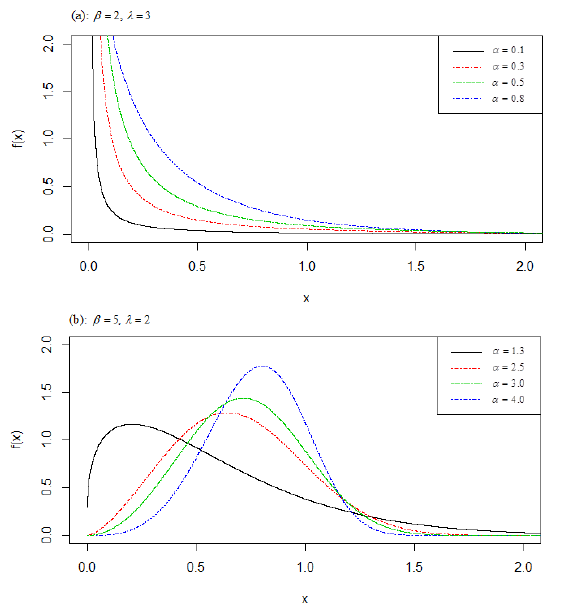
Figure 1 – Density function of the TPGLD for (a): β = 2, λ = 3; (b): β = 5, λ = 2.